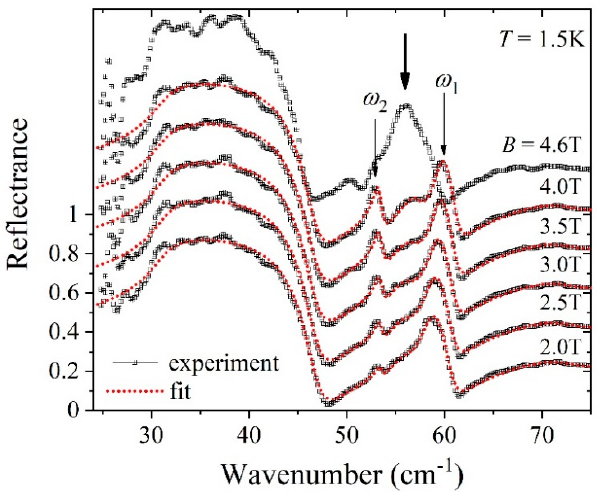
Figure 2. Measured (black symbols) and fitted by Equation (1) (red dashed line) π -polarized far- infrared reflection spectra of PrFe 3 (BO 3 ) 4 at several values of the external magnetic field B ∥ c at T = 1.5 K. Thin arrows point to the two quasi-electronic branches below B SF ≈ 4.5 T. Above B SF , they convert into a single quasi-electronic mode (indicated by a bold arrow).